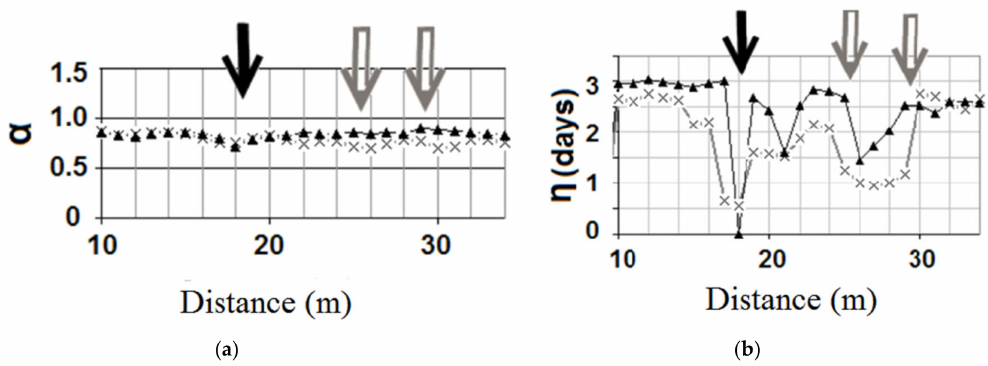
Figure 9. IRFTA analysis for the optical fiber temperature measurements in the dam downstream toe with three artificial leakage paths which are localized by arrows [9]: ( a ) The signal damping factor; ( b ) The time-lag. The cable is embedded in two di ff erent elevations at the downstream toe. The thicker line with triangle marks is associated with the temperature measurement by the cable embedded in the middle height of the dam toe while the other cable is embedded into the bottom level of the toe. (Figure reproduced with permission of the